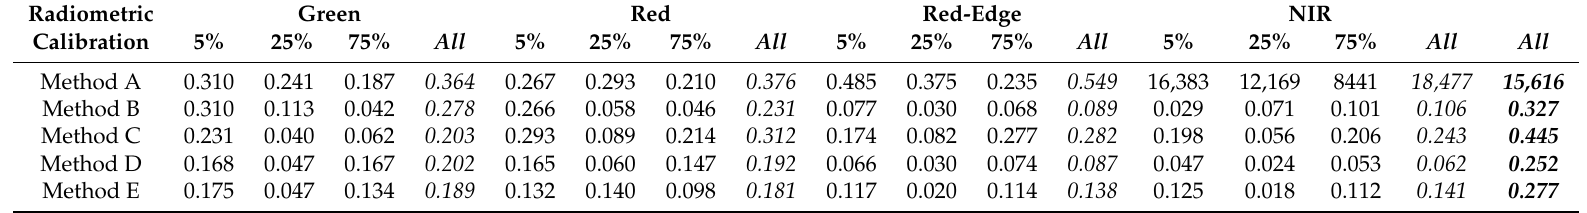
Table 5. Root-mean-square error (RMSE) values characterizing the performance of the different radiometric calibration methods across flights by multispectral band and grey value. RMSE values in the “all” columns were calculated across flights and grey values for each band, and across flights, grey values, and bands.